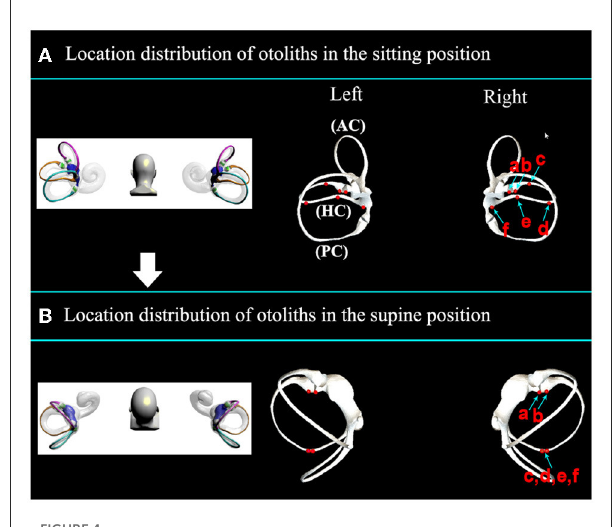
FIGURE4 (A) Distribution of otoliths in the horizontal semicircular canal in the sitting position. Otolith a is located on the short arm side (ampulla near the utricle); otolith b is located in the ampulla of the long arm; otolith c is located in the anterior of the long arm; otolith d is located in the posterior arm of the long arm; otolith e is located in the posterior arm near the opening of the utricle; otolith f is located at the opening of the utricle of the posterior arm. (B) The distribution of otoliths in the horizontal semicircular canal after stable settlement from the sitting position to the supine position.